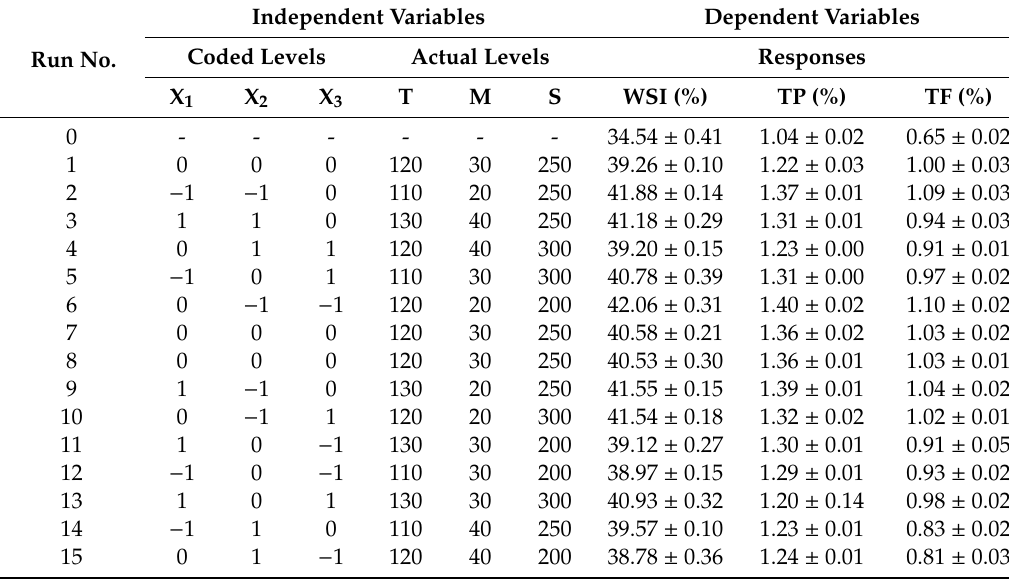
Table 1. Experimental design using Box-Behnken design and the response values.